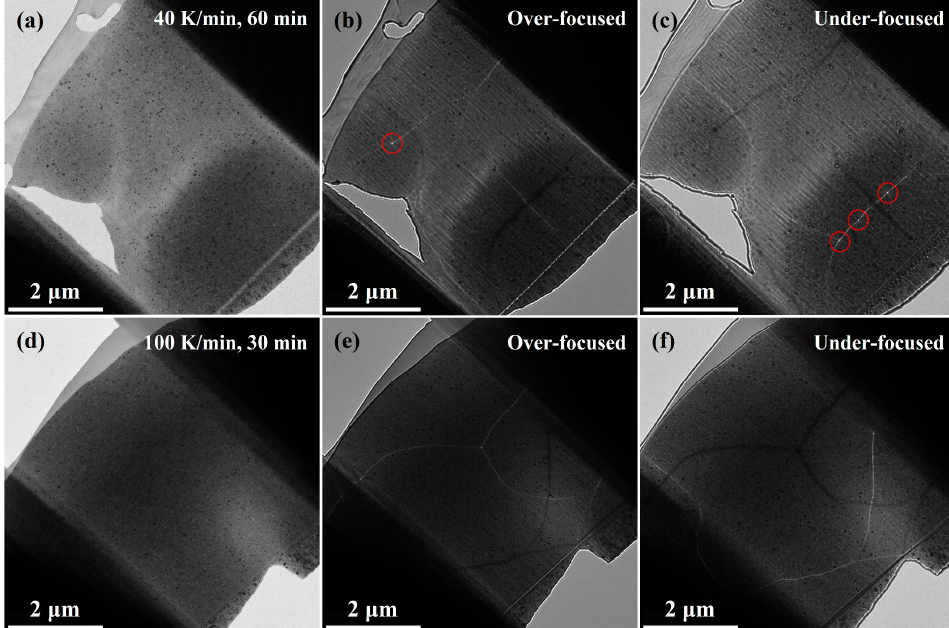
Figure 8. LTEM images of Fe 74.75 Si 8 B 10 P 3 C 2 Nb 1.5 Cu 0.75 NPCs annealed under different conditions: ( a , d ) in focus, ( b , e ) overfocused, and ( c , f ) under-focused.